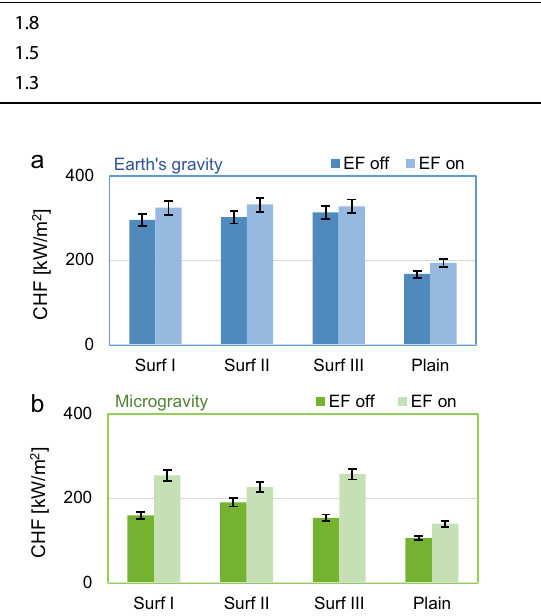
Fig. 4 Critical heat fl ux measured for the tested conditions. a Earth conditions: CHF for the four types of surfaces with and without electric fi eld. b Microgravity conditions: CHF for the four types of surfaces with and without electric fi eld. Error bars represent the measurement uncertainty (see “ Methods ”